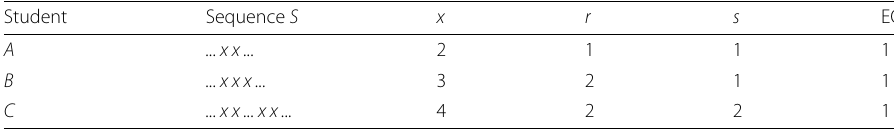
Table 3 Summary of the three scenarios